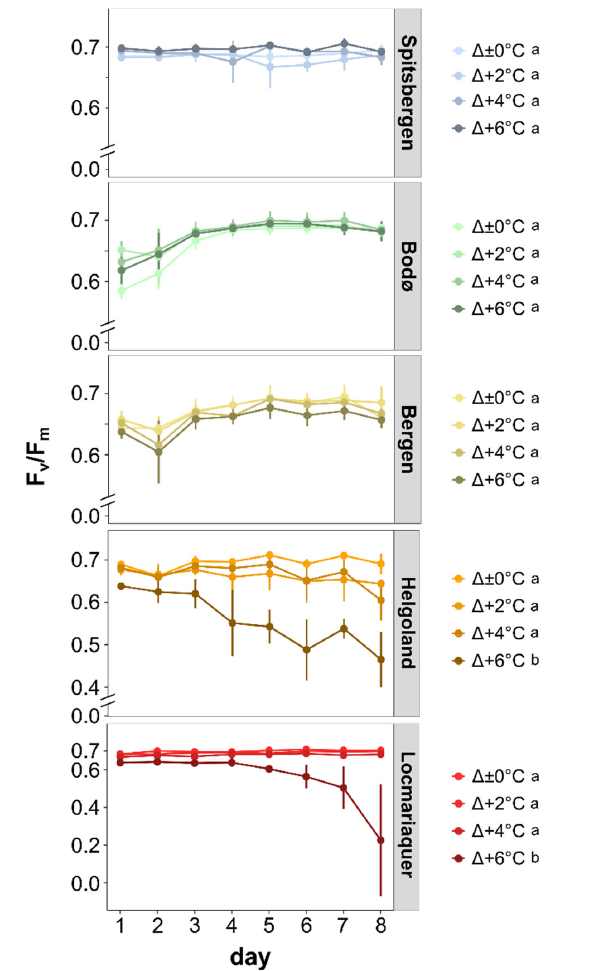
FIGURE 4 | Optimum quantum yield of photosystem II (F v /F m ) of Saccharina latissima across latitudes in Europe during the temperature-amplitude experiment. Experimental set-up: mean summer SST (control, (cid:49) ± 0 ◦ C) and temperature stress treatments: (cid:49) +2, (cid:49) +4, (cid:49) +6 ◦ C. Values are means ± SD ( n = 4). The dotted line indicates the threshold for a good physiological status. Significant differences are marked by different letters.